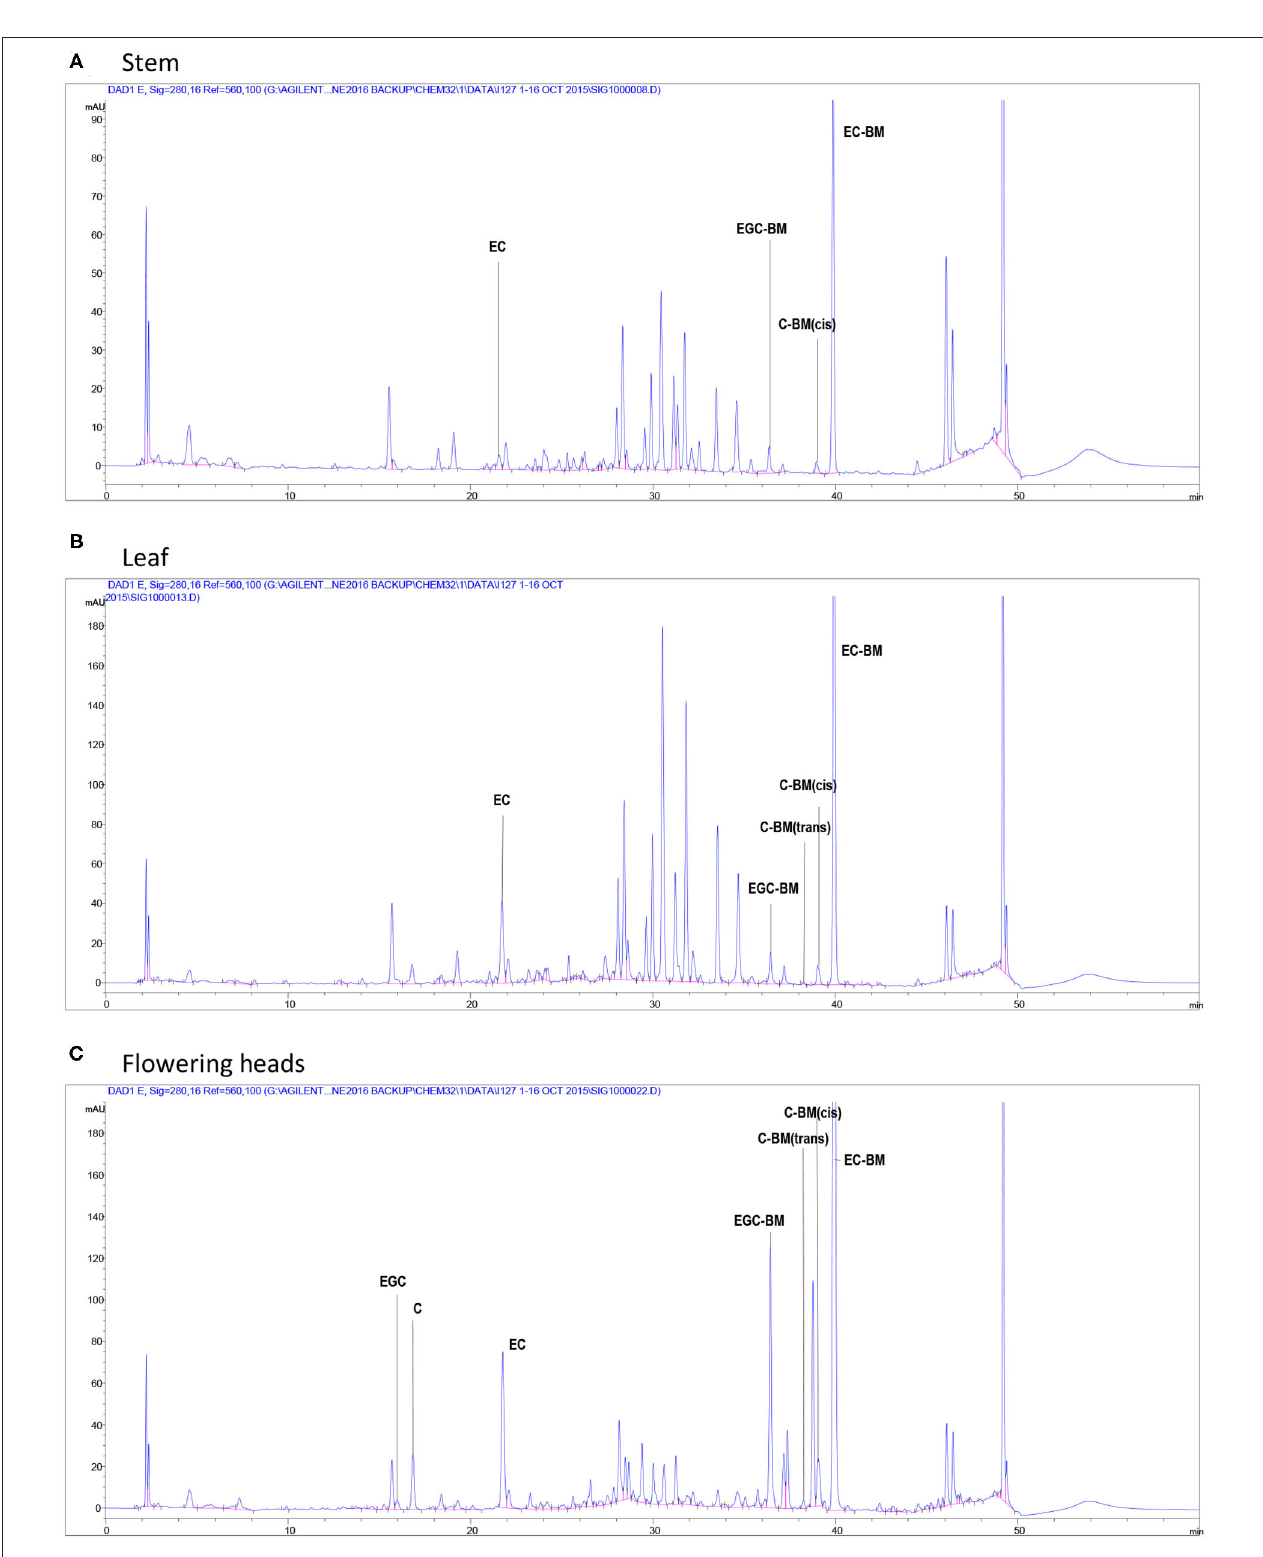
FIGURE 2 | High-performance liquid chromatography chromatograms of flavan-3-ols after in situ thiolysis of CT in stems (A) , leaves (B) , at the vegetative stage and flowering heads (C) at the early flowering stage of PPC ( Dalea purpurea Vent). Terminal units are released as a monomeric flavan-3-ols: EGC, epigallocatechin; C, catechin; EC, epicatechin; extension units are released as benzyl mercaptan (BM)-adducts: EGC-BM, 3,4- trans -epigallocatechin benzyl mercaptan; C-BM, 3,4- cis - or trans -catechin benzyl mercaptans; EC-BM, 3,4- trans -epicatechin benzyl mercaptan.